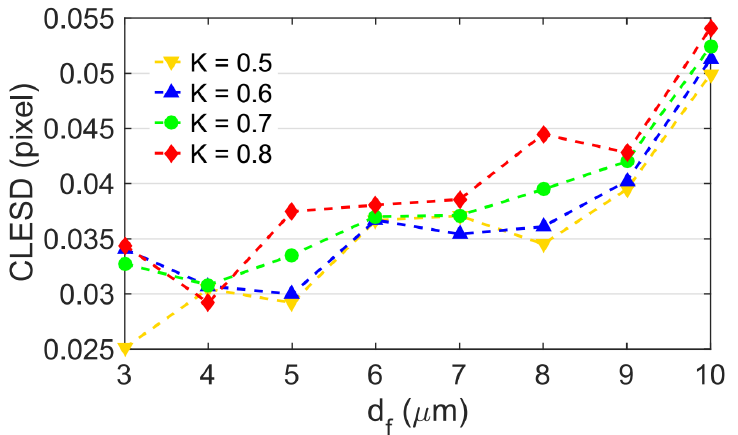
Figure 5. The impacts of different fiber diameters (3 ∼ 10 µ m) and different fill factors ( 0.5 ∼ 0.8 ) on the CLESD. When the fiber diameter was 4 µ m or 6 µ m, the fill factor had a weak effect on